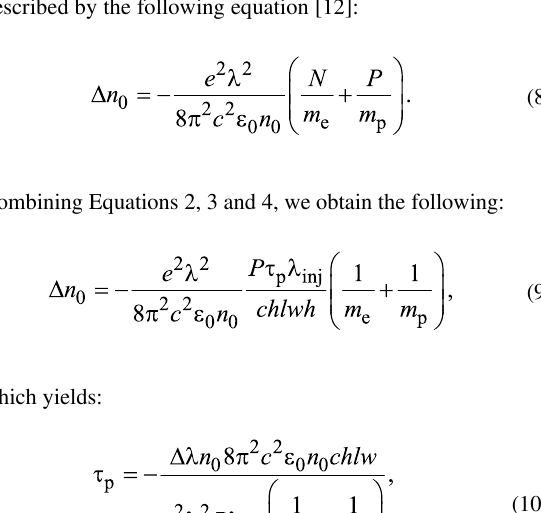
The number of photoexcited electrons, which is closely related to the number and area density of photons, forms the basis of the subsequent numerical calculation. When the modulated QCL is illuminated on the facet of its active region at an angle of 30°, almost all the laser energy is absorbed [19], so we disre- gard this loss, and the initial photoexcited electrons are gener- ated from the valence